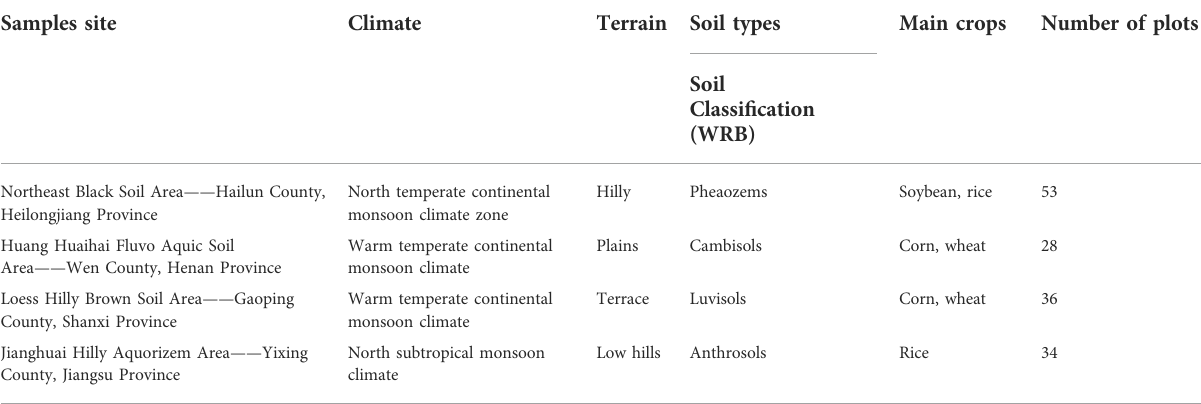
TABLE 1 Representative essential characteristics of sample